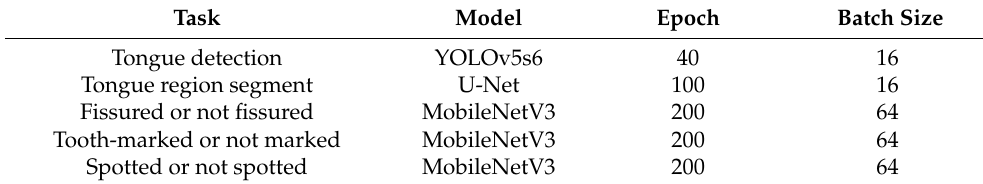
Table 4. The precise configuration of the